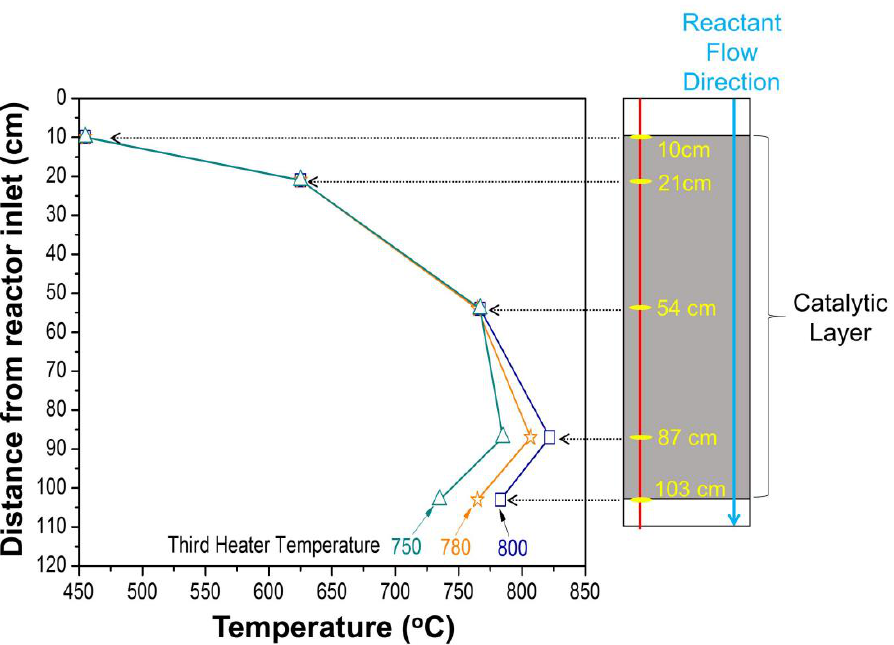
Figure 2. Bench-scale reaction system for the steam reforming of methane (hydrogen production rate of 10 L/min): ( a ) photograph of the unit and ( b ) schematic diagram of the unit.